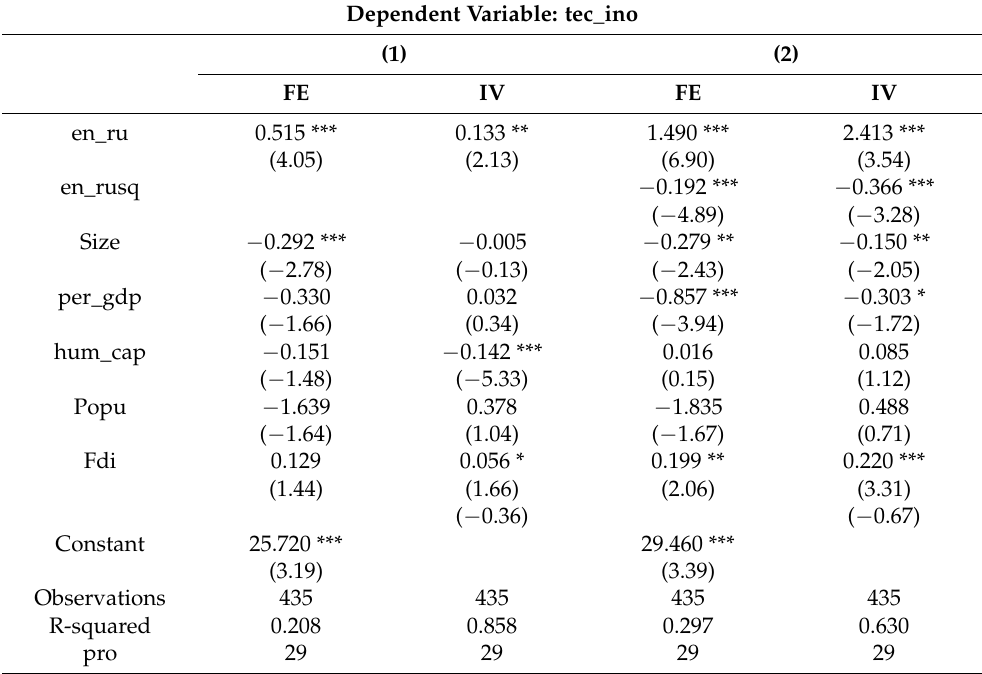
Table 4. Total sample regression.